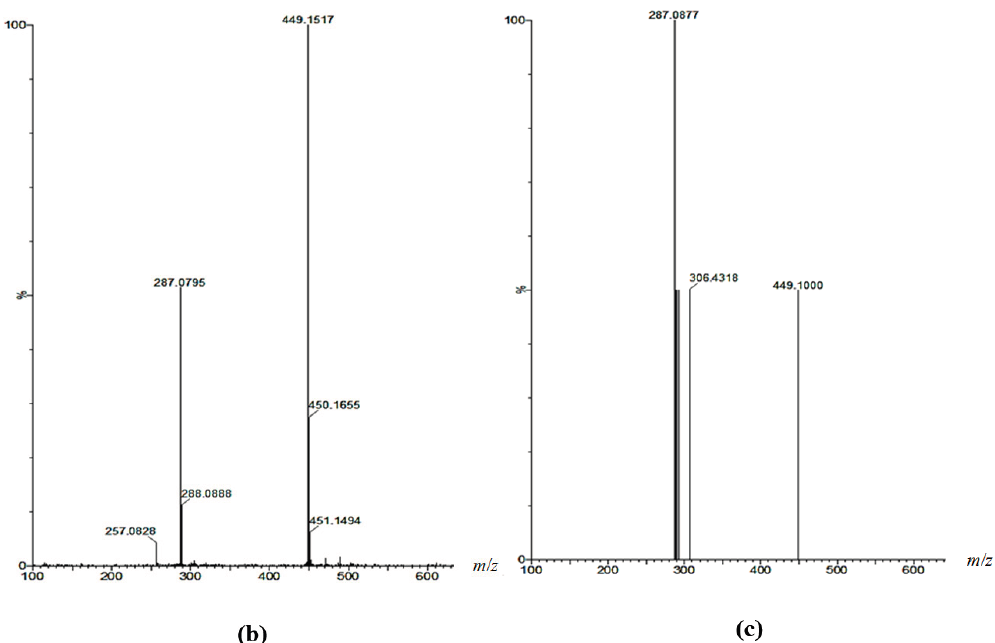
Figure 6. LC chromatogram ( a ) of anthocyanin at different stages of bread-making as well as LC-MS ( b ) and LC-MS/MS of cyanidin-3-glucoside (cy-3-glu) ( c ) in flour.